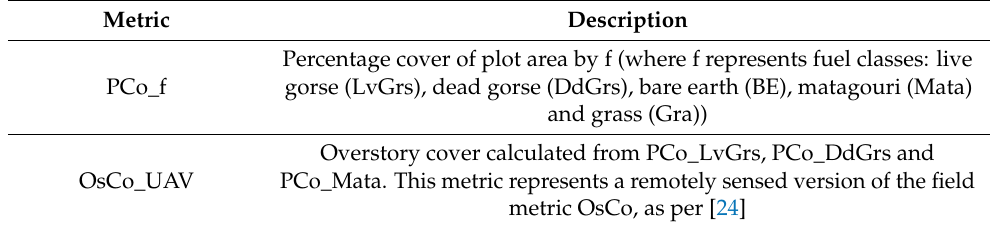
Table 4. Metrics calculated from semantic segmentation results for fuel class. Metric Description Percentage cover of plot area by f (where f represents fuel classes: live PCo_f gorse (LvGrs), dead gorse (DdGrs), bare earth (BE), matagouri (Mata) and grass (Gra)) Overstory cover calculated from PCo_LvGrs, PCo_DdGrs and OsCo_UAV PCo_Mata. This metric represents a remotely sensed version of the field metric OsCo, as per